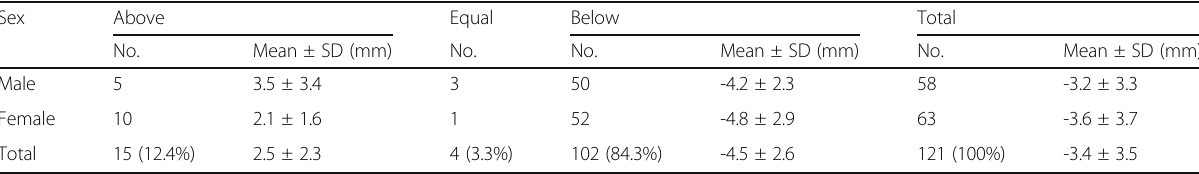
Table 4 Relationship of mandibular foramen to occlusal